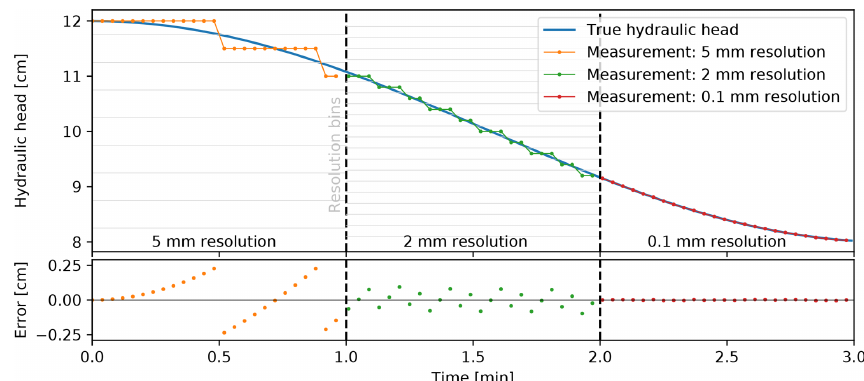
Figure 3. Illustration of the influence that the instrument resolution has on the measurement error: a continuous, time-variable head is measured at discrete time intervals by instruments with analogue-to-digital conversion resolution of 5, 2 and